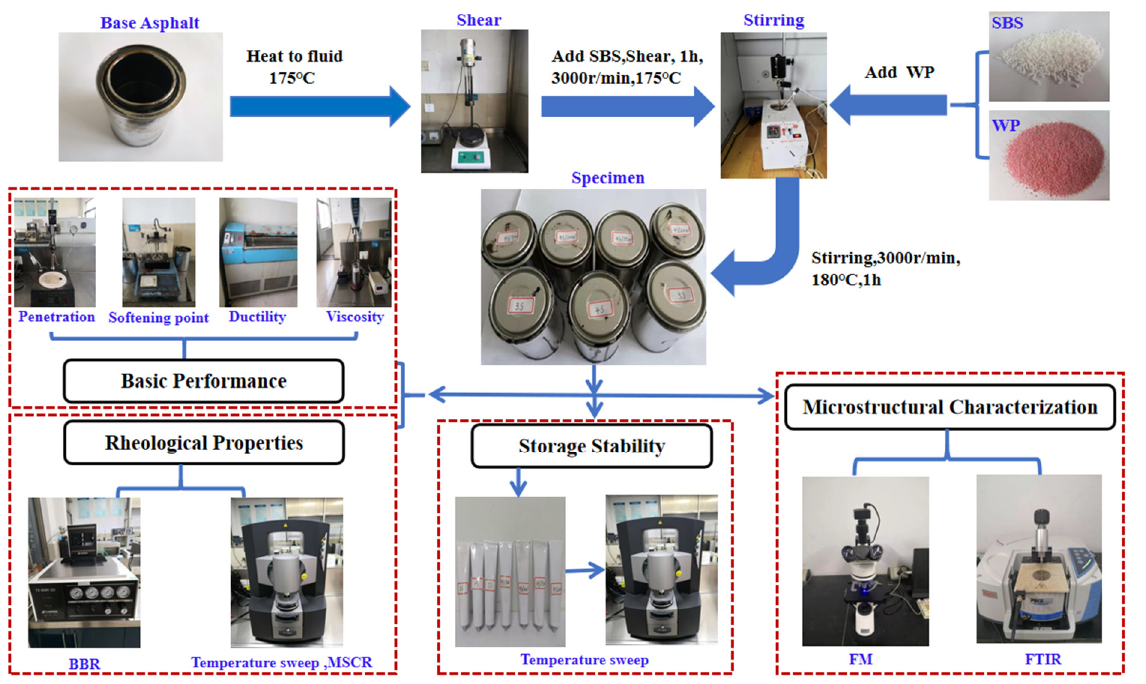
Figure 1. Flowchart of experiment planning of WPU/SBS composite modified asphalt.